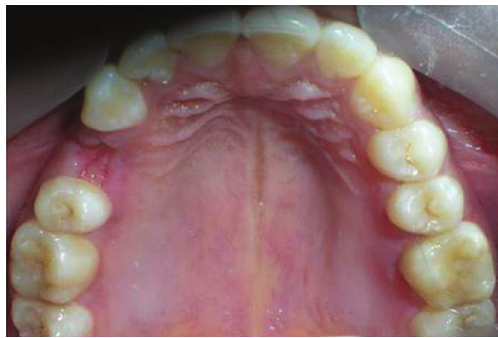
Figure 24: occlusal view of upper arch, seven days posttreatment showing excellent periodontal